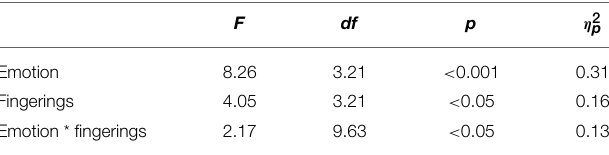
TABLE 2 | Results of the Two-Way repeated-measures ANOVA of emotion and fingerings on keystroke dynamics (as reflected by Vp/d). F df p η 2 p